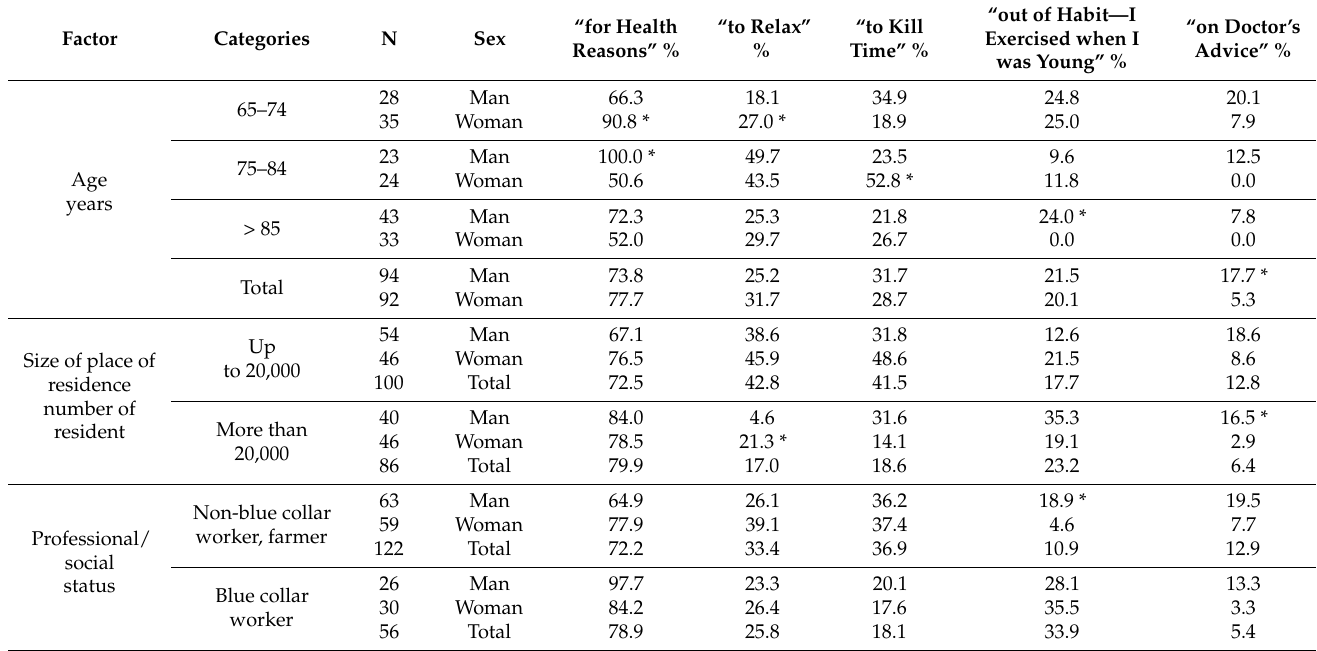
Table 2. Reasons for taking up Leisure Time Physical Activity (LTPA) by the respondents with regard to age, sex, place of residence and socio-professional status in